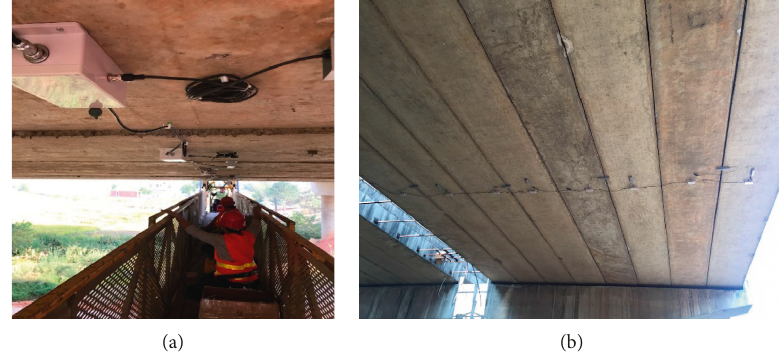
Figure 18: Site installation of strain measurement